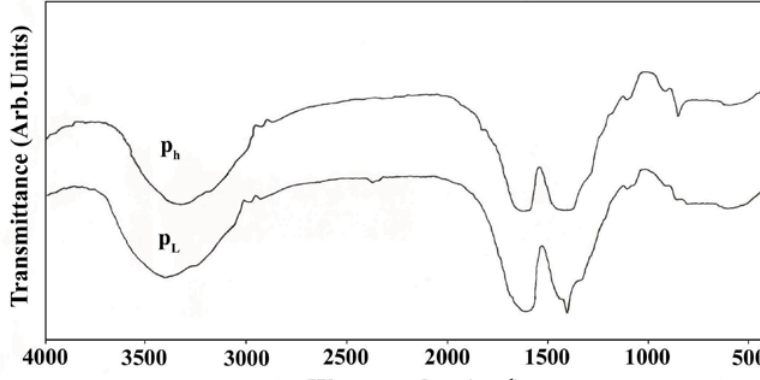
Figure 2. IR spectra of the dried gels P